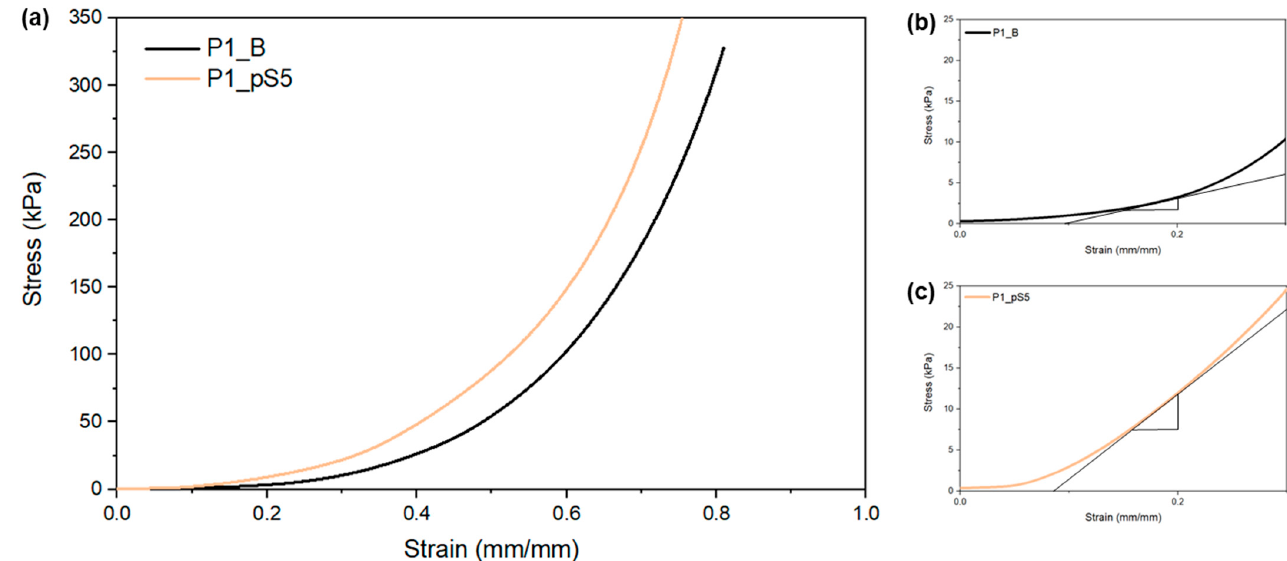
Figure 4 . ( a ) Compression stress–strain curves for scaffolds with 5.54 wt.% of pSPIONs (P1_pS5 (orange)) and without pSPIONs (P1_B (black)); ( b ) Enlargement of the compression stress-train curve obtained for scaffolds P1_B, evidencing the slope at 20% strain; ( c ) Enlargement of the compression stress-train curve obtained for scaffolds P1_pS5, evidencing the slope at 20% strain.